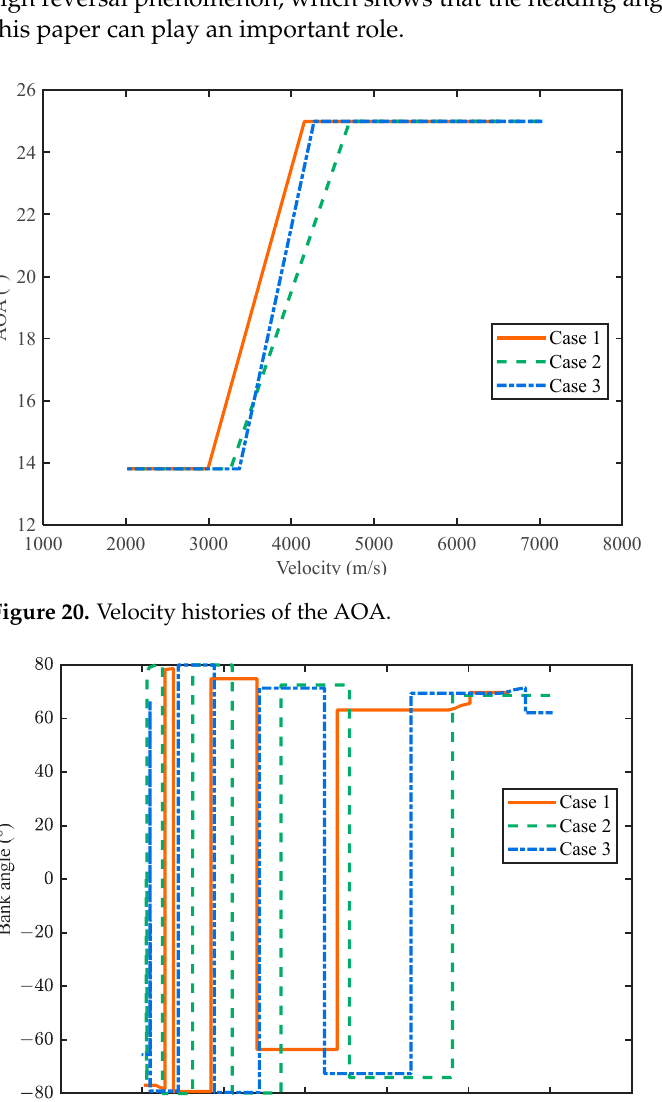
Figure 19. Resistance acceleration reentry corridor.